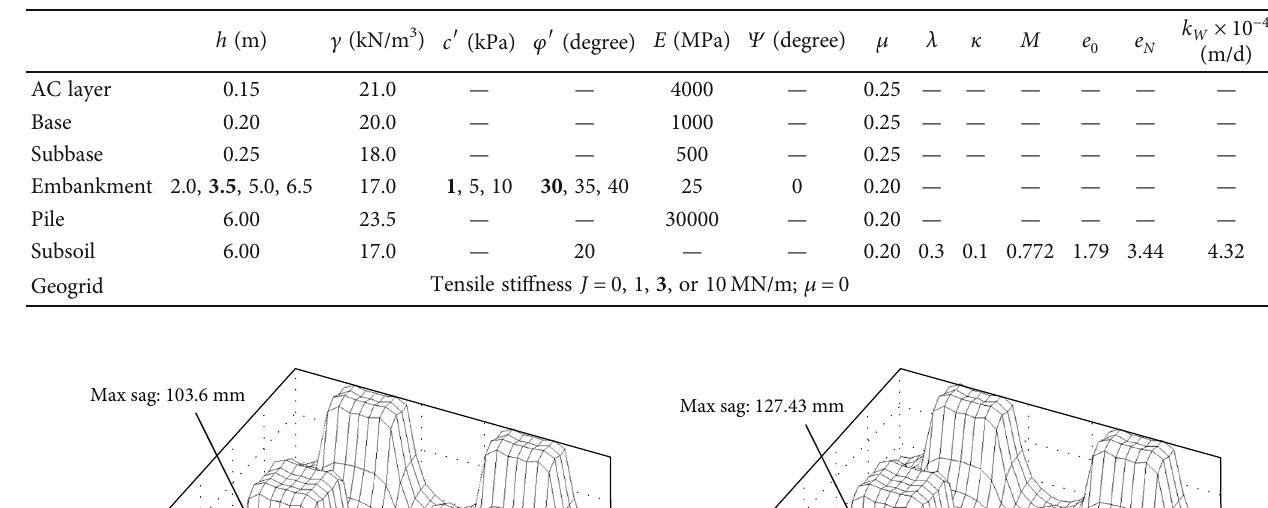
Figure 1: Layout of the reinforced piled embankment. Table 1: The material parameters used in the fi nite element analysis.